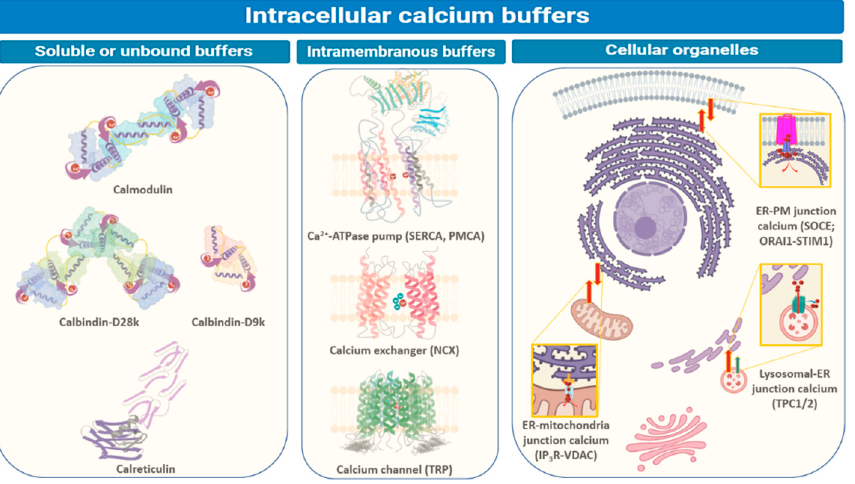
Figure 1. Types of intracellular Ca 2+ buffers.